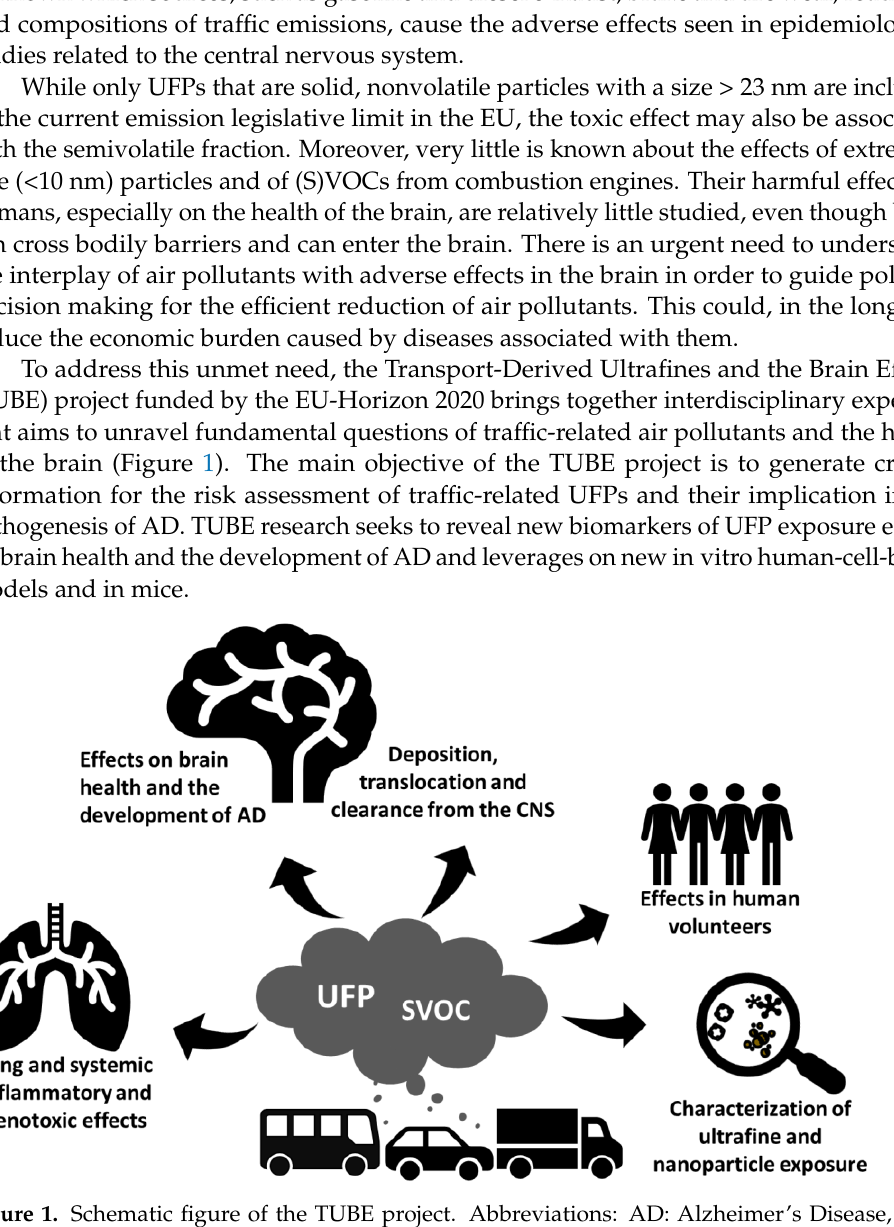
Figure 1. Schematic figure of the TUBE project. Abbreviations: AD: Alzheimer’s Disease, CNS: central nervous system, UFP; ultrafine particles, SVOC: semivolatile organic compounds.